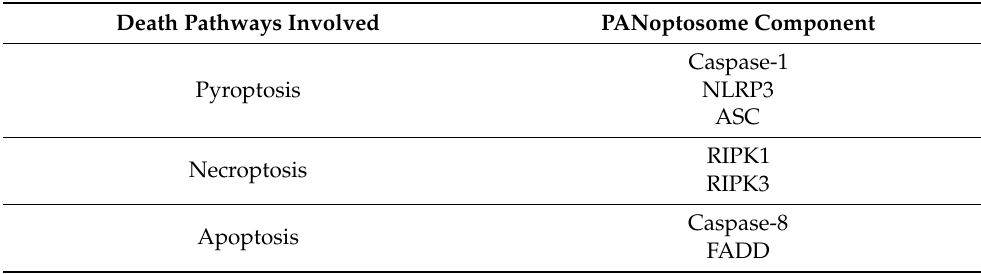
Table 1. Molecular components of the PANoptosome induced by TNF and IFN- γ stimulus after SARS-Cov-2